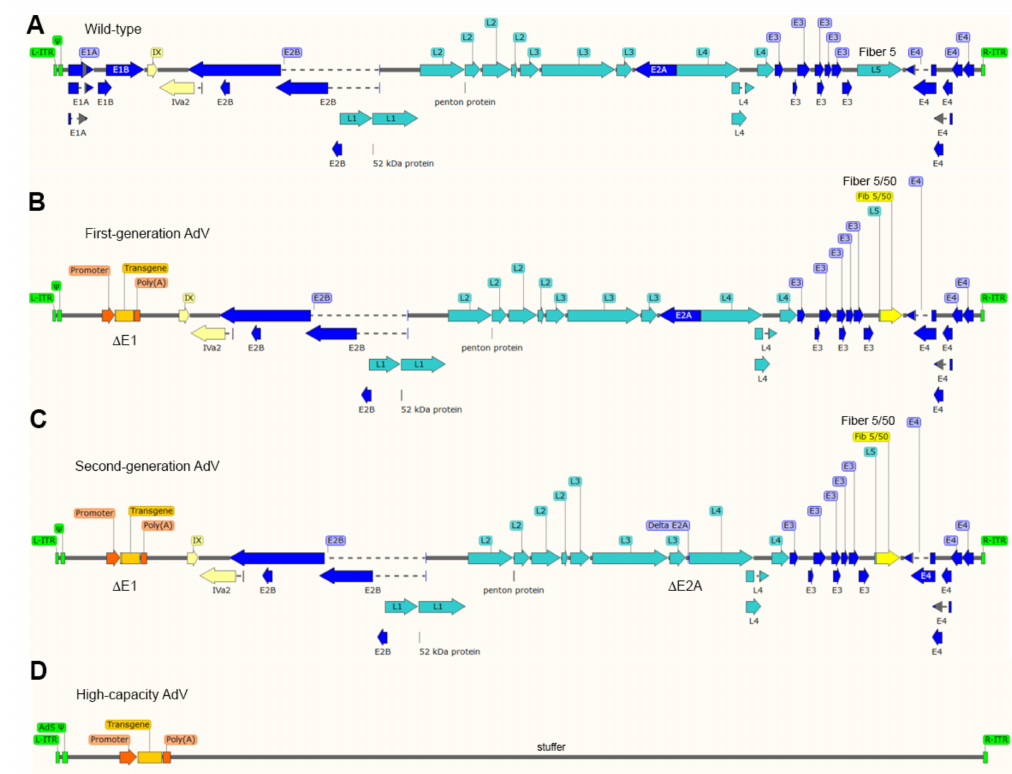
Figure3. Schematicsofwild-typeandrecombinantadenoviruses.( A )Genomestructureoftheprototypic human adenovirus serotype 5 drawn in relation to the genome structures of ( B ) first-generation ( E1 -deleted), ( C ) second-generation ( E1 - and E2A -deleted), and ( D ) third-generation or